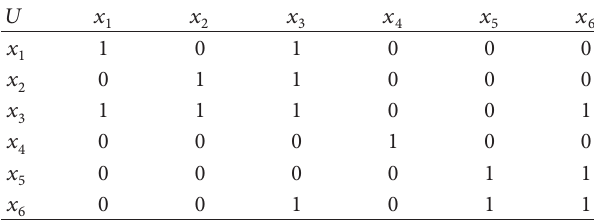
Table 8: The neighborhood of objects on 𝐵{𝑎 1 ,𝑎 2 } .